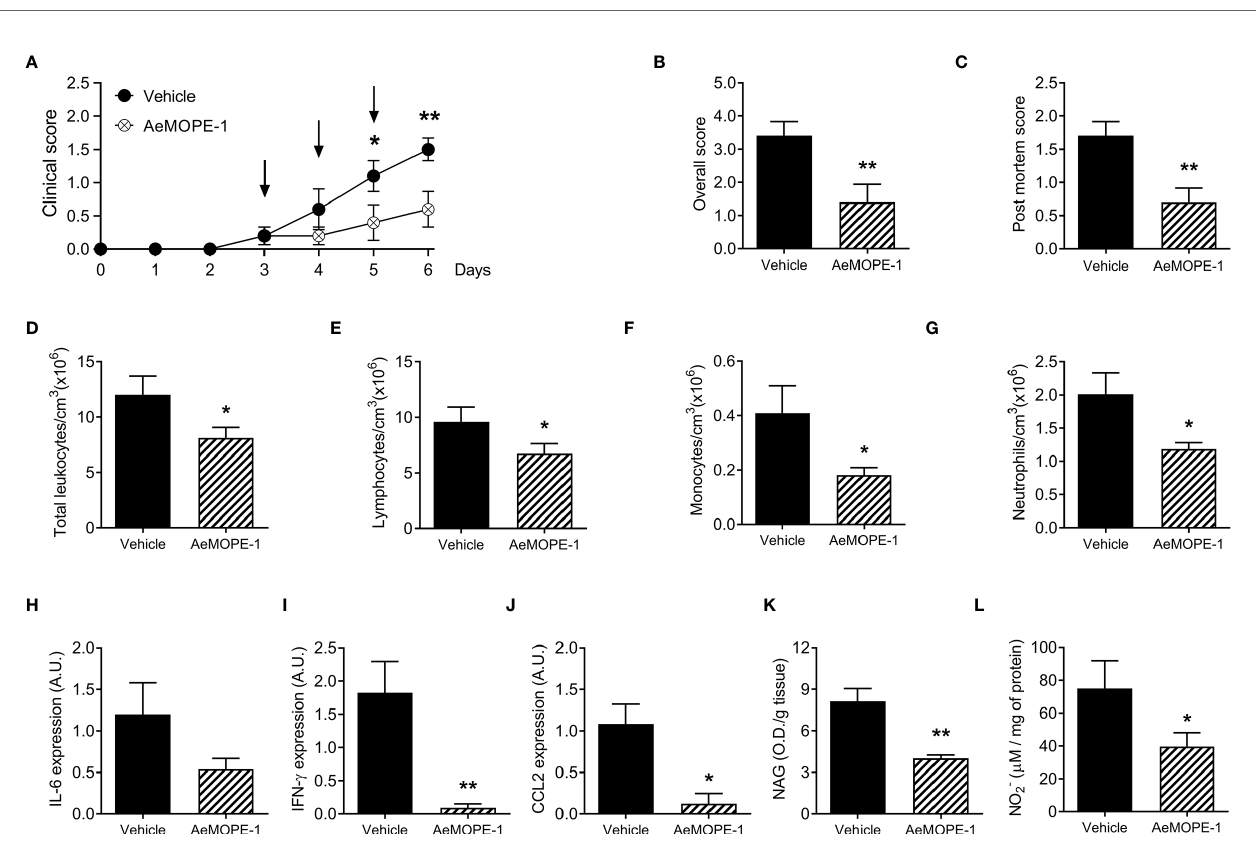
FIGURE 6 | Treatment of mice with syn-AeMOPE-1 ameliorates the clinical signs of experimental colitis. Mice were divided into two groups and received 3% DSS in their drinking water for 6 days. One group was treated daily with syn-AeMOPE-1 (1 µg/animal) while the other received an equal dilution of DMSO, both in 0.9% saline, at the beginning of the clinical signs, as indicated by the arrows. (A) Clinical score was assessed daily until the time of euthanasia of animals while (B) overall clinical score and (C) post-mortem score were evaluated on the day of euthanasia. (D) Total circulating leukocytes, (E) lymphocytes, (F) monocytes and (G) neutrophils were counted on the day of euthanasia. Results are expressed as the mean ± SEM (n = 10 animals/group). Data from one representative experiment of two independent experiments are shown. * P ≤ 0.05 and ** P ≤ 0.01 versus “ Vehicle ” group – Student ’ s t test. Expression of (H) IL-6, (I) IFN- g and (J) CCL2 by RT- qPCR, as well as the (K) activity of macrophages by NAG quanti fi cation and (L) nitric oxide levels by Griess reaction, were evaluated in gut homogenates after euthanasia. Results are expressed as the mean ± SEM (n = 4-5 animals/group) from one representative experiment of two independent experiments. * P ≤ 0.05 and ** P ≤ 0.01 versus “ Vehicle ” group – Student ’ s t